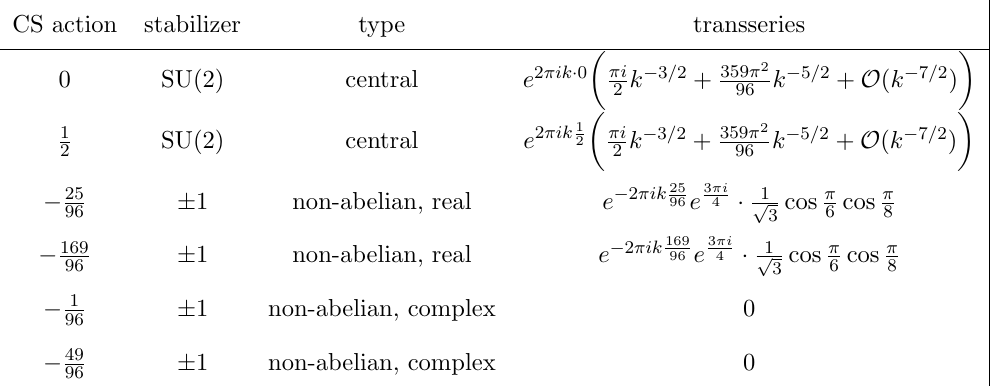
Table 10 . Transseries and classi(cid:12)cation of (cid:13)at connections on M ( CS invariant type holonomy angles